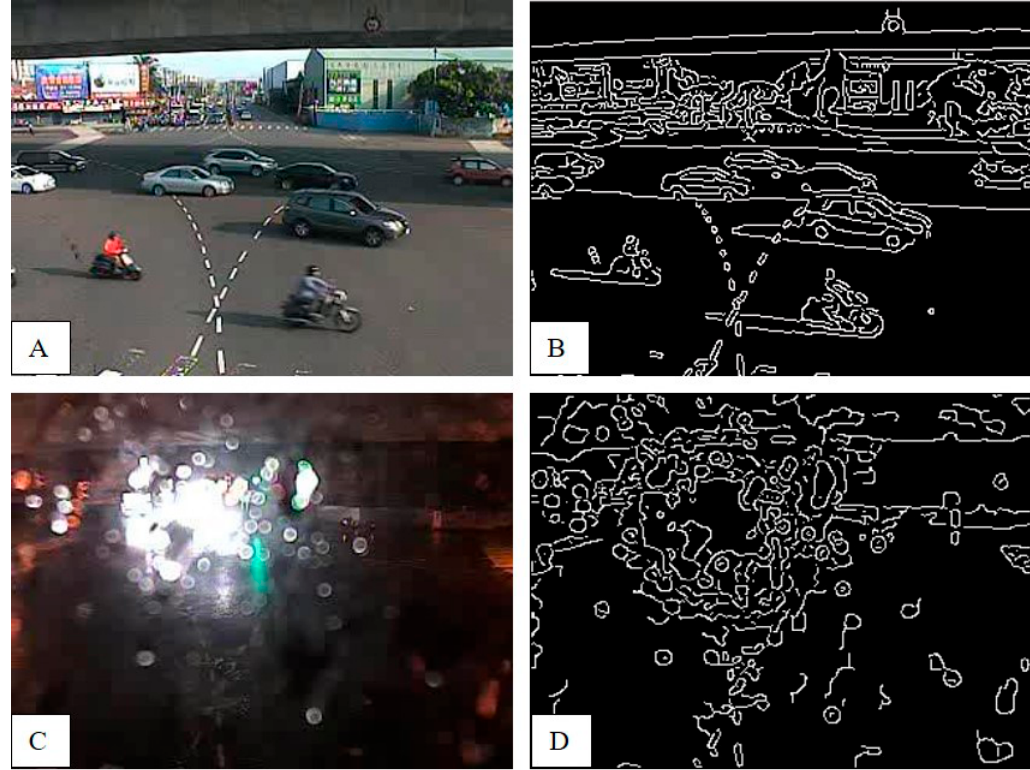
Figure 4. The edge analysis. ( A ) CCTV image in normal case. ( B ) The edge detection of A. ( C ) CCTV image with raindrops. ( D ) The edge detection of C.